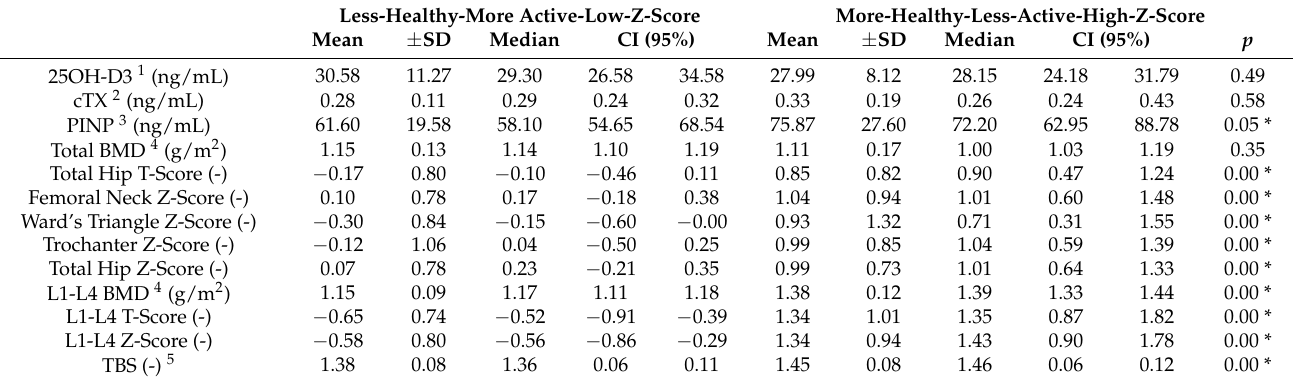
Table 4. Bone mineral density and bone metabolism markers between the two clusters of